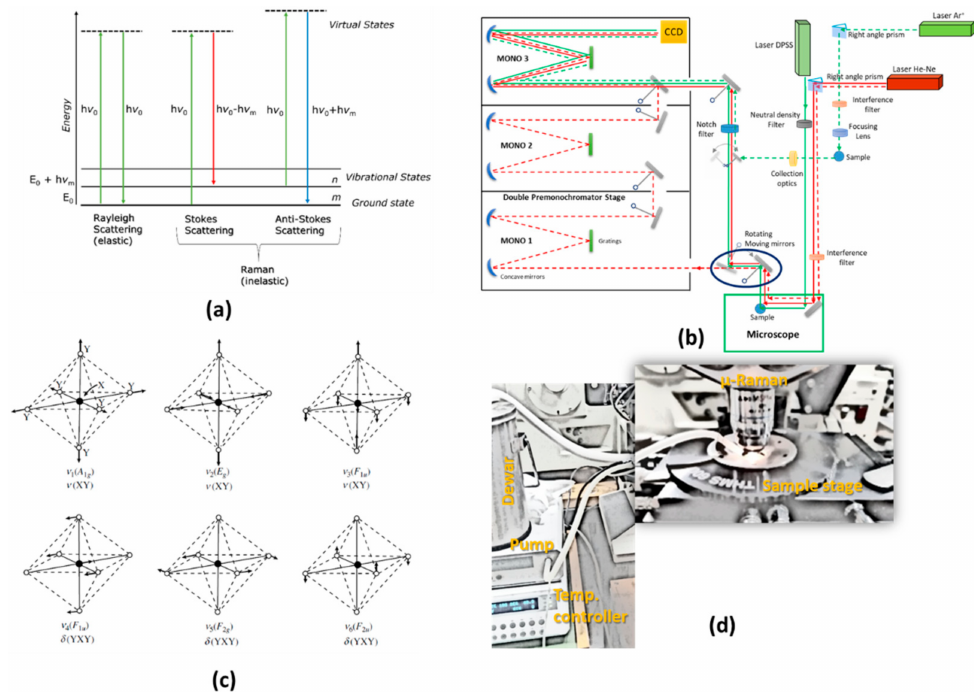
Figure 1. ( a ) Diagram of the Rayleigh and Raman scattering processes, ( b ) Illustration of a typical Raman setup operating either with a mono- or triple configuration, ( c ) Normal modes of vibration of octahedral XY 6 molecules, ( d ) Sketch image of the main compartments for temperature-dependent micro-Raman